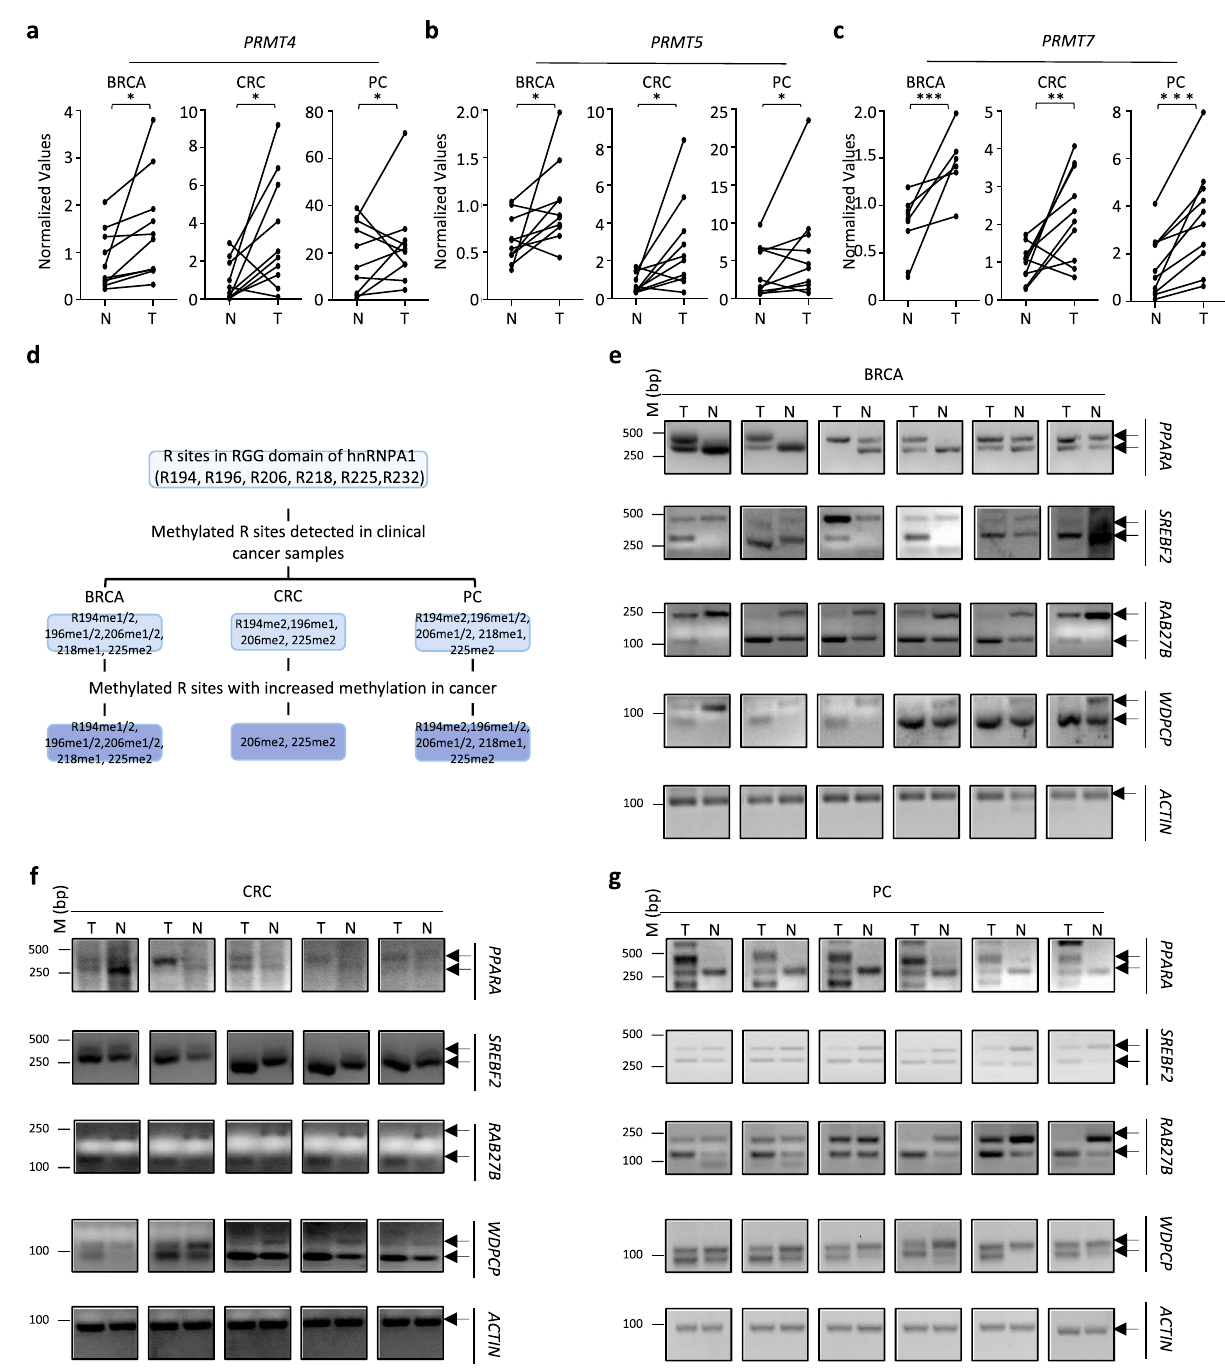
Fig. 6 PRMT4, 5, 7, and hnRNPA1 arginine methylation were over-presented in multiple types of cancers. a – c Clinical samples of breast cancer (BRCA) ( n = 10), colorectal cancer (CRC) ( n = 10) and prostate cancer (PC) ( n = 10) were subjected to RNA extraction and RT-qPCR analysis to examine the expression of PRMT4 ( a ), PRMT5 ( b ), and PRMT7 ( c ). Pearson correlation coef fi cient of the expression of PRMT4 , PRMT5 , and PRMT7 between normal and tumor samples is 0.60, − 0.50, and − 0.17 in BRCA, 0.12, 0.21, and − 0.05 in CRC, and 0.48, 0.74, and 0.69 in PC, respectively. (* P < 0.05, ** P < 0.01, *** P < 0.001 by paired Student t -test, two-tailed). d Arginine methylation sites in RGG domain of hnRNPA1 protein that could be detected and quanti fi ed in clinical samples of BRCA, CRC, and PC were shown. e – g Clinical samples of BRCA ( e ), CRC ( f ), and PC ( g ) were subjected to alternative splicing analysis as described in Fig. 4f. Source data are provided as a Source data fi